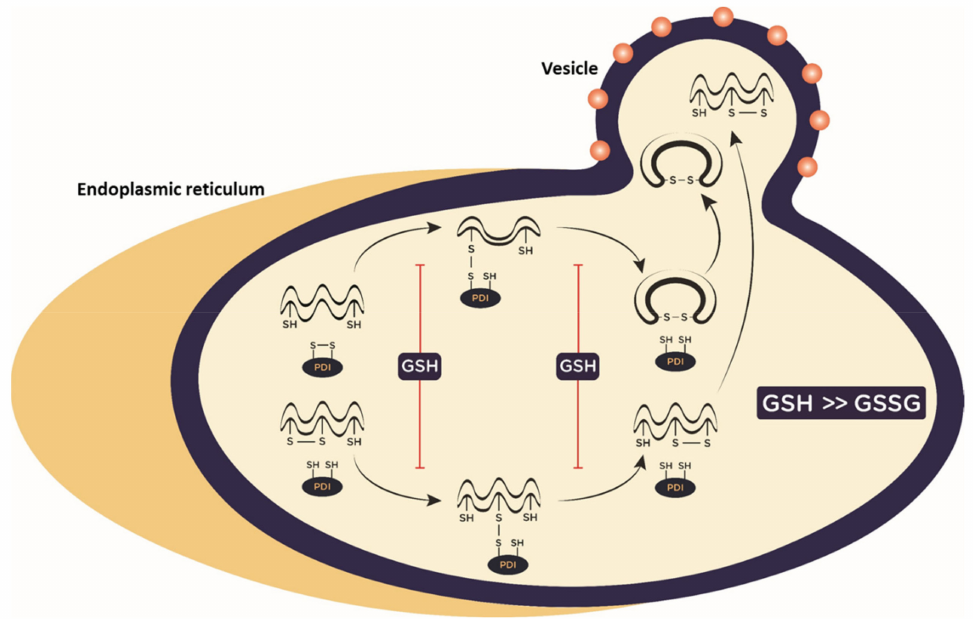
Figure 2. Inhibition of protein folding catalyzed by PDI through GSH in the endoplasmic reticulum (ER). PDI plays important roles in oxidative folding of proteins, catalyzing disulfide bond formation (above) or disulfide isomerization (below). GSH increase, by influencing GSH/GSSG ratio inside the ER, inhibits essential disulfide bond formation in viral proteins preventing the subsequent transport through the secretory system of the cell. GSH: reduced glutathione; GSSG: oxidized glutathione; PDI: protein disulfide